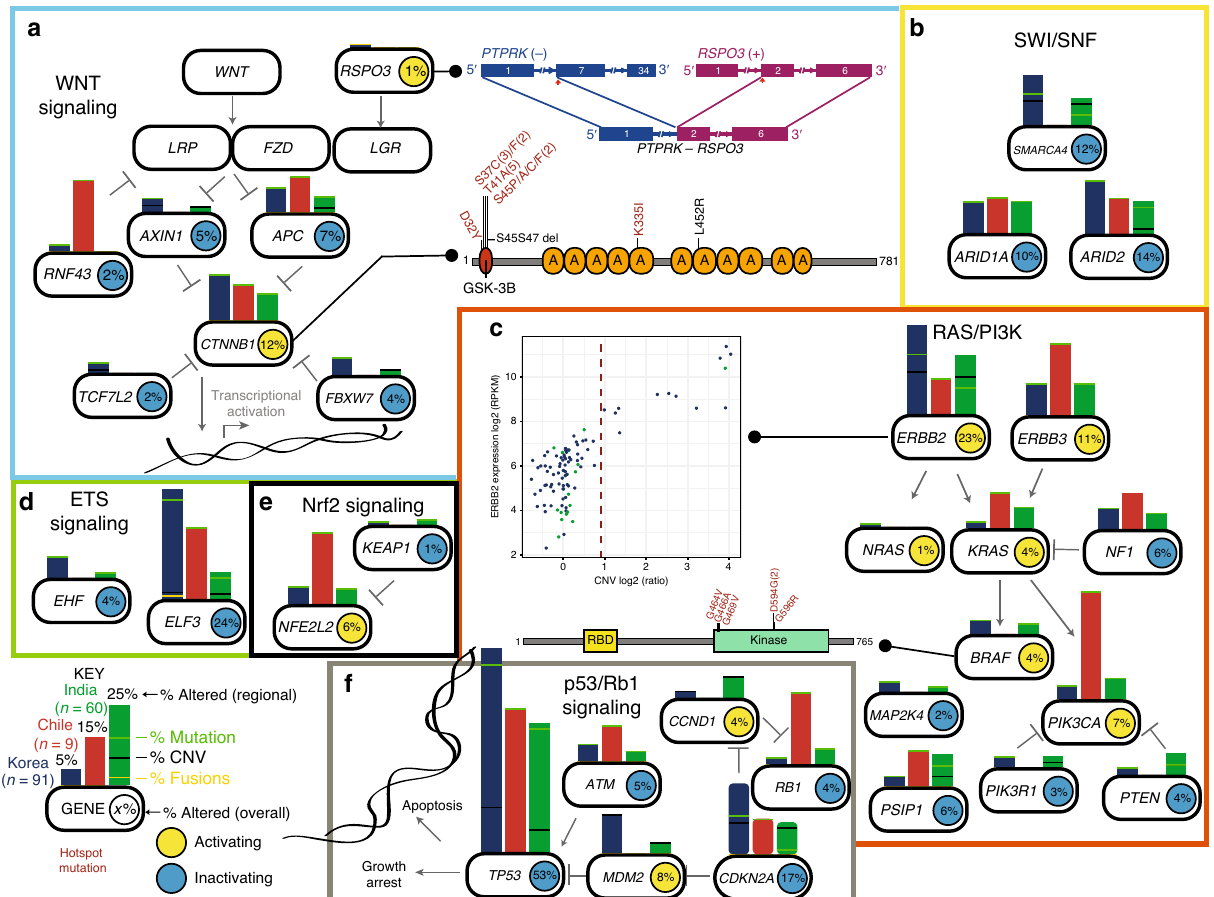
Fig. 6 Integrated analysis of pathway alterations observed in GBC. Alterations in the WNT ( a ), SWI/SNF ( b ), RAS/PI3K ( c ), ETS signaling ( d ), Nrf2 Signaling ( e ), and p53/Rb1 ( f ) pathways. Smooth edge rectangles indicate genomically altered genes; bars indicate frequency of genomic alterations by origin (blue, Korea ( n = 94); red, Chile ( n = 9); green, India ( n = 64)). Horizontal lines within bars indicate frequency of mutations (green), fusions (yellow) or copy number loss all-against-all sample comparison of germline variants and con fi rmed the patient tumor-normal pairing. Variant calling . Sequencing reads were mapped to UCSC human genome (GRCh38) using BWA software 50 set to default parameters. Local realignment, duplicate marking, and variant calling of germline variants were performed as described previously 51 . Strelka 52 was used for somatic variant calling on tumor and its matched normal BAM fi le. Known germline variants represented in dbSNP Build 131 53 or found in the ExAC database 54 at an allele frequency ≥ 0.1% were fi ltered out for all samples. The effect of all nonsynonymous somatic mutations on gene function was predicted using PolyPhen 55 . Variants were annotated using Ensembl (release 86). TCGA mutation data used in mutation rate comparison across tumors were retrieved using the CGDSR R package from cBioPortal 56,57 . Additional data QC . Sample origins were con fi rmed using principal component analysis using 5709 common variants 54 in exomes from this study. Samples were colored according to their known country of origin and clustered using the fi rst and second principal component. Mutant variants with RNA-seq reads count ≥ 1 con fi rmed their expression. Signi fi cantly mutated genes had to have at least one third of their mutations validated by RNA-seq and also have a minimum of half their mutant calls con fi rmed by the MuTect somatic variant calling algorithm 58 . Recurrently mutated codons that could not be con fi rmed by RNA-seq were excluded from hotspot analysis, but were retained in the mutation list. MSI status determination . MANTIS (Microsatellite Analysis for Normal-Tumor InStability) was used to detect microsatellite instability for all paired GBC samples. Microsatellites within the reference genome (GRCh38) were identi fi ed using RepeatFinder, which is included in MANTIS, with default options. MANTIS was run with the options recommended for whole-exome data: -mrq 20.0 -mlq 25.0 -mlc 20 -mrr 1 --threads 8. Samples with a score >0.35 were predicted to be MSI.